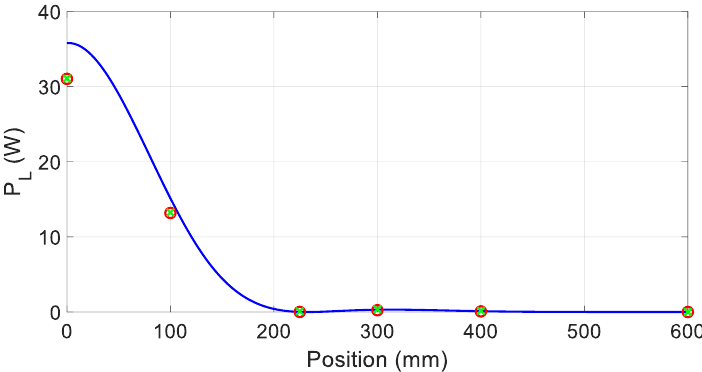
Figure 9. Power transferred to the load obtained from FEM (red circle) and power comprehensive of the losses obtained from FEM (green stars) and by computation (blue line).